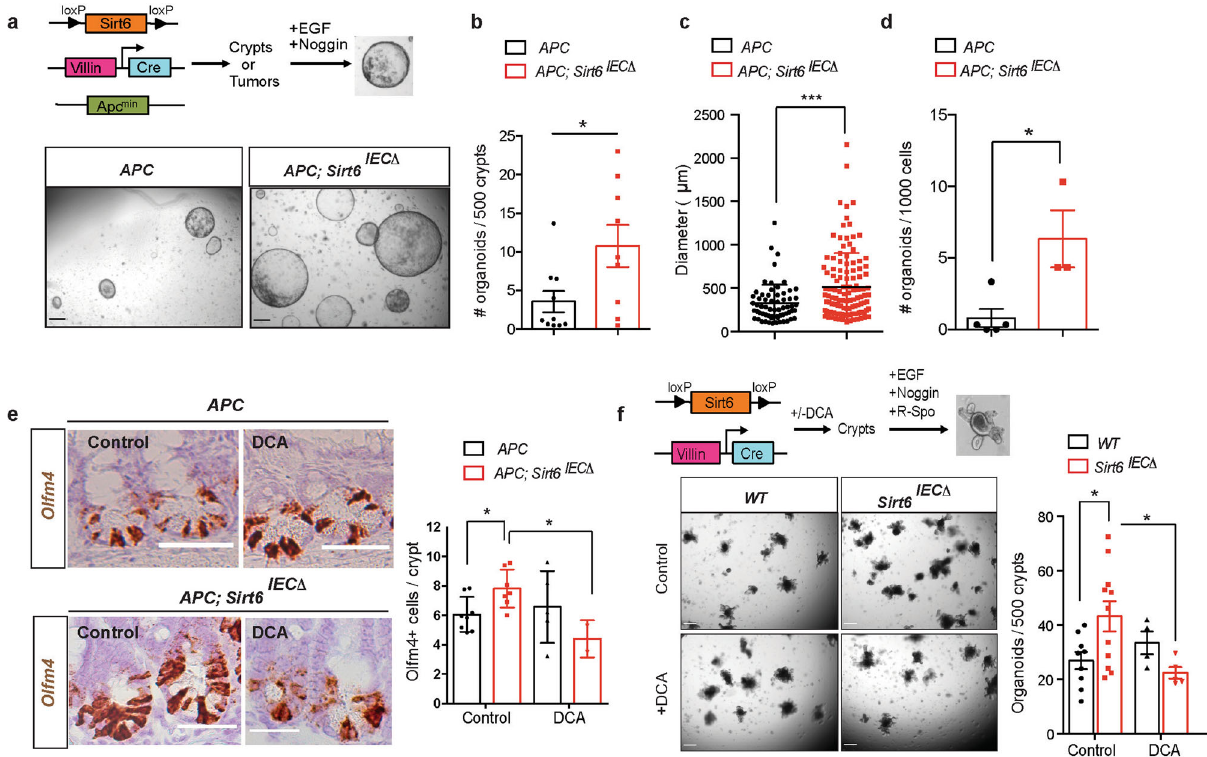
Fig. 1 SIRT6-dependent metabolic reprogramming regulates tumor initiation in the intestine. a Tumor initiating potential was assayed by organoid formation experiments in EN medium. The pictures illustrate adenoma-derived organoids from APC and APC; Sirt6 IEC Δ mice. Scale bars, 300 μ m. b Quanti fi cation of number of organoids derived from APC ( n = 10) and APC; Sirt6 IEC Δ ( n = 9) mice ( p = 0.0263). Each experiment was done in triplicate and data is presented as mean ± SEM. c Organoid size was quanti fi ed by averaging two diameter measures in organoids derived from APC and APC; Sirt6 IEC Δ ( n = 2) mice. The average size of all organoids is represented as mean ± SD ( p = 0.003). A total of 64 organoids from APC mice and 129 from APC; Sirt6 IEC mice were analyzed. d Number of organoids derived from adenomas from APC ( n = 5) and APC; Sirt6 IEC Δ ( n = 3) mice ( p = 0.017). Each experiment was done in triplicate and data is presented as mean ± SD. e Representative images of ISH for Olfm4 (left) and quanti fi cation of Olfm4 + cells in APC and APC; Sirt6 IEC Δ untreated ( n = 8 and n = 7, respectively) and treated with DCA ( n = 5 and n = 3, respectively). P = 0.0169 ( APC compared to APC; Sirt6 IEC Δ ) and p = 0.0135 ( APC; Sirt6 IEC Δ control compared to DCA-treated). Data is presented as mean ± SD. Scale bars, 100 μ m. f ISC activity was measured by organoid formation assays in ENR medium. Left, representative images of 7-day organoids from control and Sirt6 IEC Δ mice (untreated and treated with DCA). Right, quanti fi cation of organoid number from control and Sirt6 IEC Δ mice untreated ( n = 9 and n = 11, respectively) and treated with DCA ( n = 4 and n = 5, respectively). P = 0.0273 ( WT compared to Sirt6 IEC Δ ) and p = 0.0279 ( Sirt6 IEC Δ control compared to DCA-treated). Each experiment was done in triplicate and data is presented as mean ± SEM. Scale bars, 300 μ m Two tailed t -test (for comparisons between two groups) or one-way ANOVA (for comparisons of more than two groups) were used to determine statistical signi fi cance between groups (* p < 0.05; ** p < 0.01; *** p < 0.001). Source data are provided as a Source Data fi